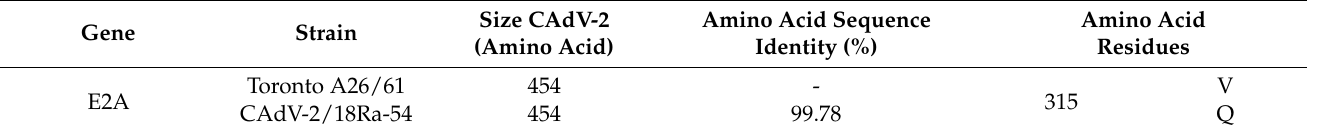
Table 3. Comparison of amino acid sequence identity between Toronto A26/61 strain (GenBank accession number U77082) and CAdV-2/18Ra-54.